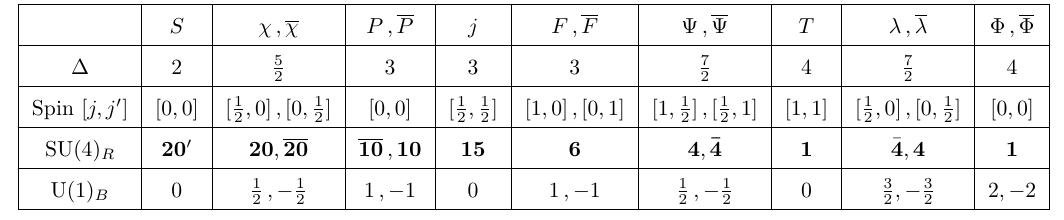
Table 1 . Operators in the N = 4 stress energy tensor multiplet and their scaling dimensions ∆ , spins [ j, j 0 ] of the Euclidean Lorentz group SO(4) ∼ = SU(2) × SU(2) , irreps of the R -symmetry group SU(4) R , and charges of the bonus symmetry group U(1) B